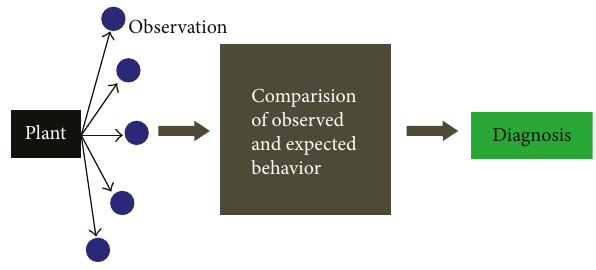
Figure 1: Typical diagnostic procedure